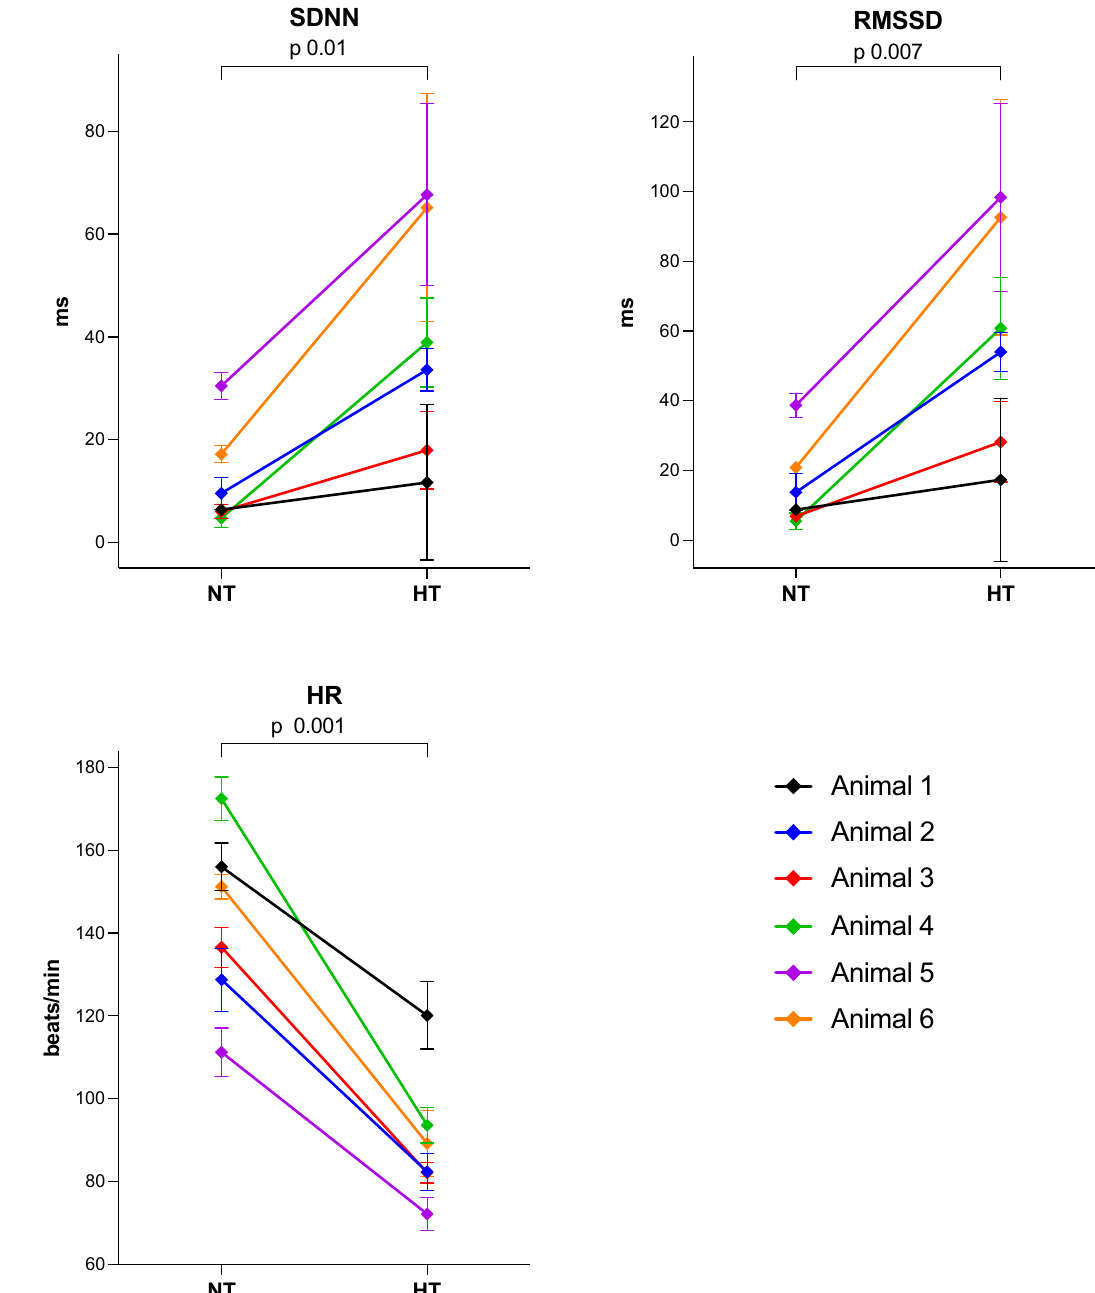
Figure 1. HRV time domain variables and heart rate in six healthy, anaesthetised, newborn piglets exposed to 3 h of normothermia (38.5–39.5 °C) and 3 h of hypothermia (33.5–34.0 °C). Data are presented as mean with SD of 3 h of normothermia (NT) and mean with SD of 3 h of hypothermia (HT). P -value comparing NT with HT with paired t-test. NT: Normothermia; HT: Hypothermia; SDNN: Standard deviation of normal-to-normal interval; RMSSD: Root mean square of successive differences; logVLF: log-transformed power in the very low frequencies; logLF: log-transformed power in the low frequencies; logHF: log-transformed power in the high frequencies; HR: heart